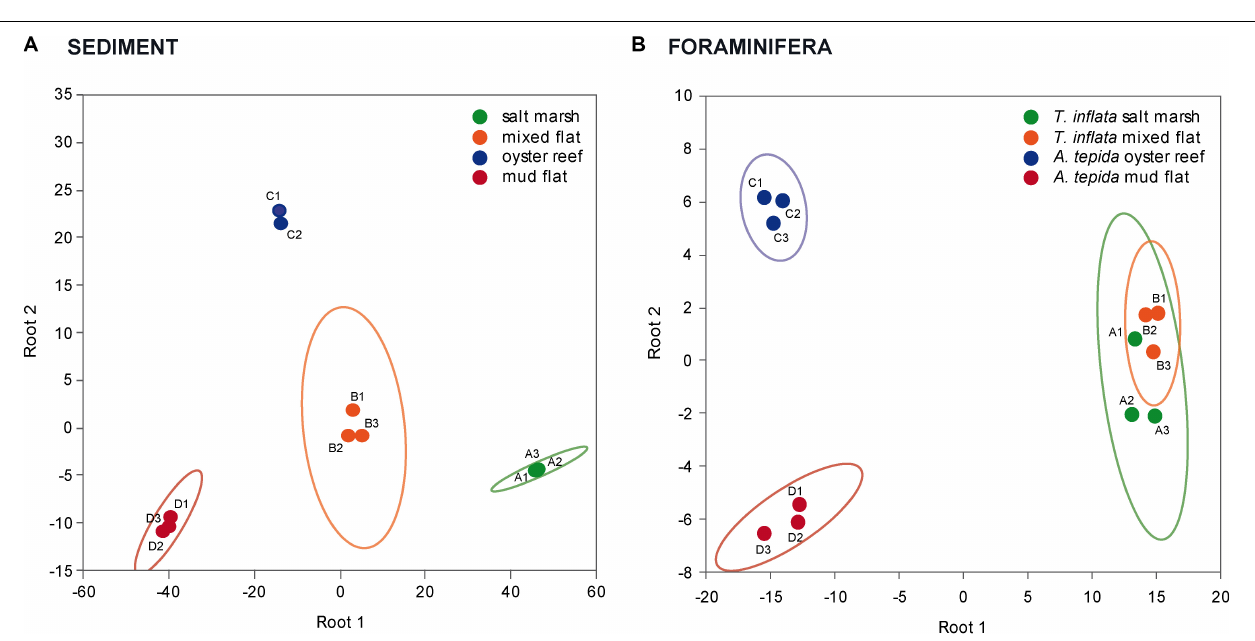
FIGURE 2 | Fatty acid composition in sediments and foraminifera. Principal component analysis (PCA) of (A) sediment FAs and (B) foraminifera FAs of Trochammina inflata and Ammonia tepida in salt marsh, mixed flat, oyster reef and mud flat. PCA is based on percentage biomarker FAs of total FAs (logit-transformed); eigenvalues of PCA of sediment FAs: axis 1 = 0.5739 and axis 2 = 0.2533; eigenvalues of PCA of foraminifera FAs: axis 1 = 0.5770 and axis 2 = 0.1808. Dashed colored circles (drawn by eye) were added in order to visualize the fatty acid distribution between the habitats: green algae (green; 18:2 ω 6, 18:3 ω 3 and 18:1 ω 7), brown algae (brown; 20:4 ω 6), diatoms (light blue; 16:1 ω 7 and 20:5 ω 3) and bacteria (gray; i15:0, a15:0, 15:0, i16:0, i17:0, cy17:0, 17:0).